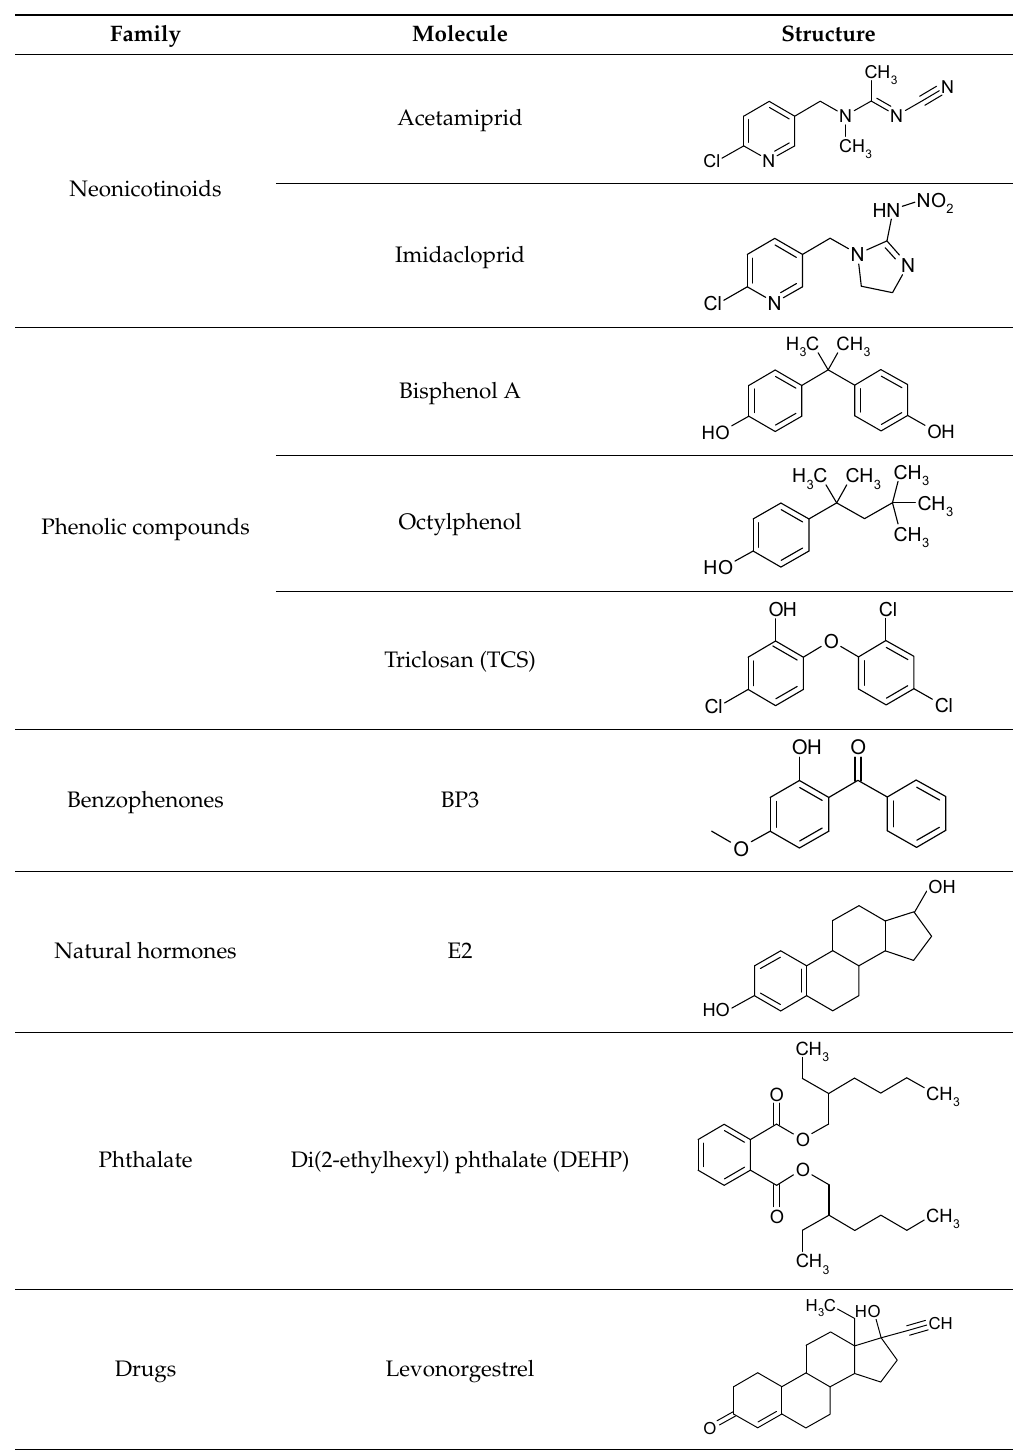
Table 2. Structures of representative EDCs.